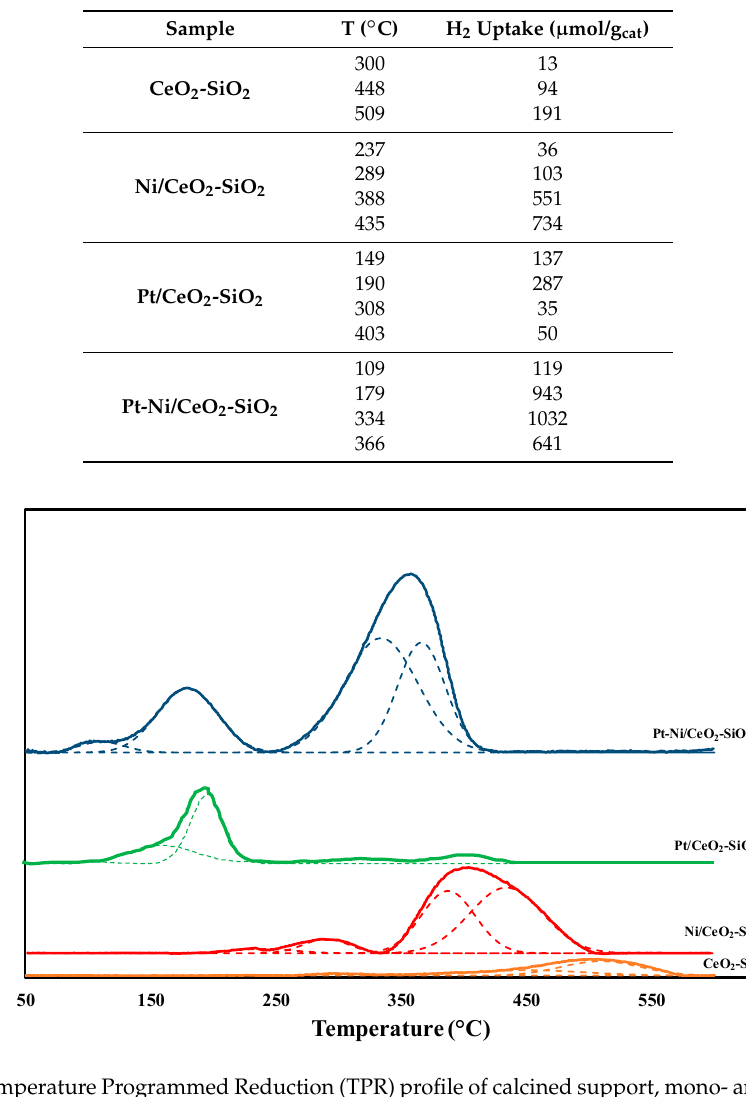
Figure 2. Temperature Programmed Reduction (TPR) profile of calcined support, mono- and bi-metallic catalysts after baseline subtraction (the deconvoluted peaks were represented by dotted lines). Table 2. Quantitative results of TPR analysis.